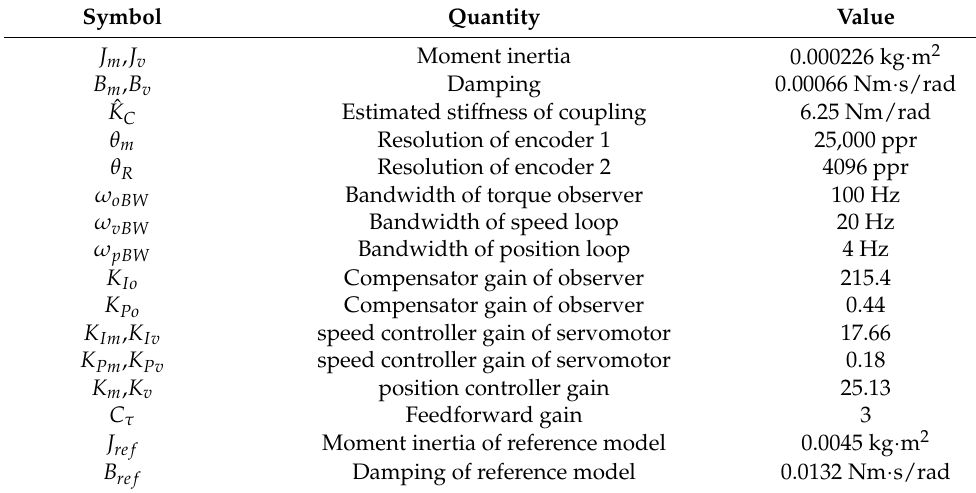
Table 1. Parameters of system